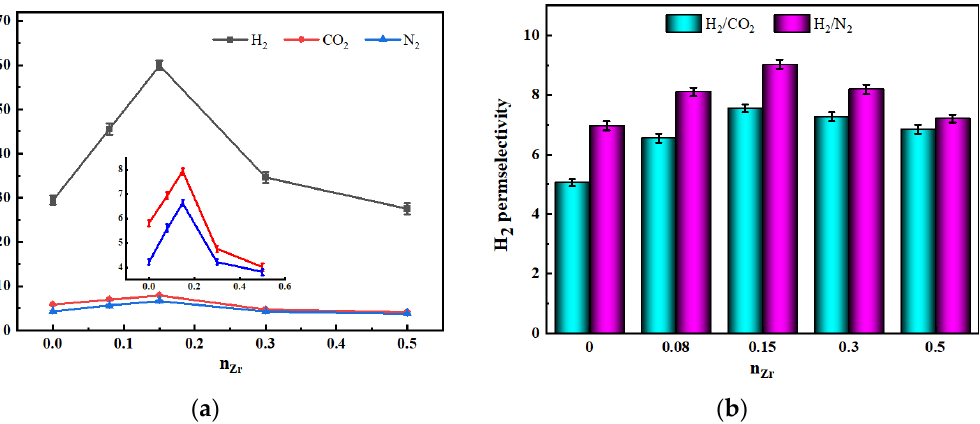
Figure 10. ( a ) Gas permeance and ( b ) H 2 permselectivities of ZrO 2 -MSiO 2 membranes with various n Zr and 0% DCCA addition at a pressure difference of 0.1 MPa and 25 °C. SEM images of surface topography for MSiO 2 and ZrO 2 -MSiO 2 (n Zr = 0.15) membranes